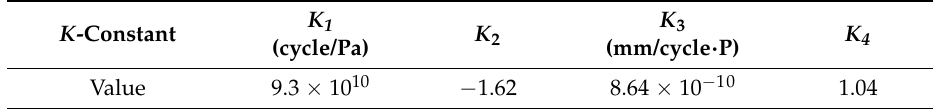
Table 2. K-constants for the Darveaux model.